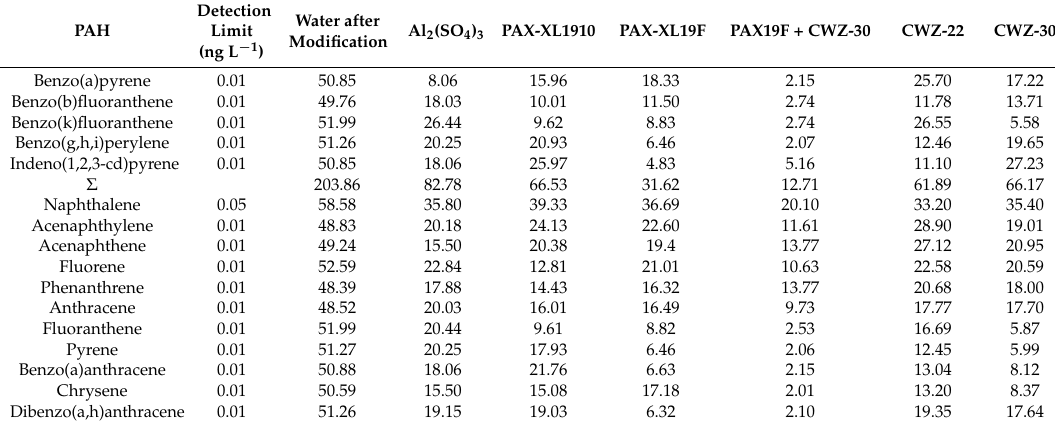
Table 4. The concentration (ng L − 1 ) of PAH in water after the coagulation process, the adsorption and the coagulation enhanced by powdered activated carbon. Detection PAH